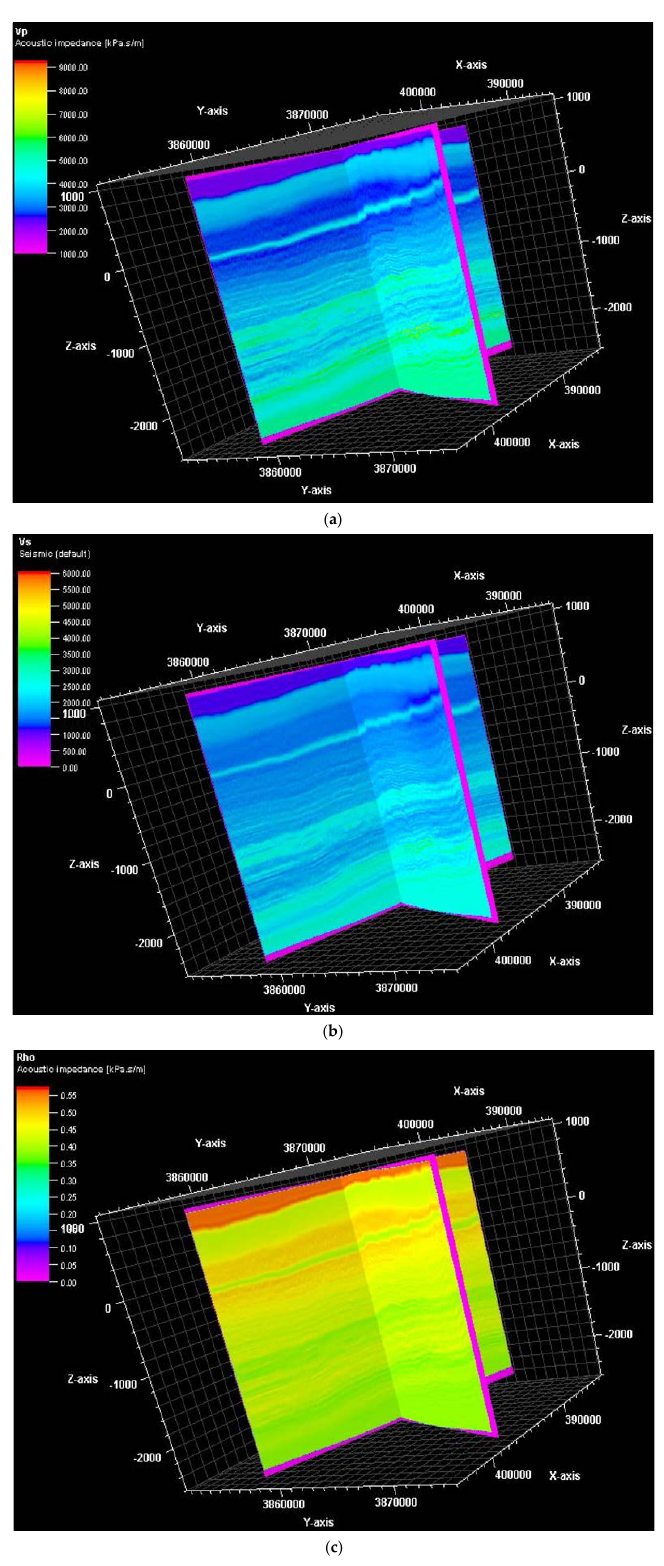
Figure 5. Volumes generated using seismic inversion: ( a ) acoustic velocities (m/s), ( b ) shear rates, ( c ) density AI (k.Pa.s/m).